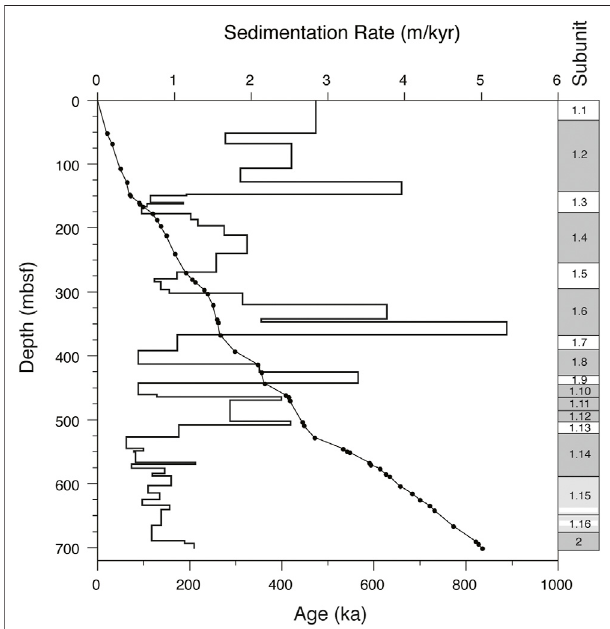
FIGURE8| CombinedplotshowingtheRPI-calibratedagemodel(black dots connected by a line) for Hole M0079A and the calculated sedimentation rates (continuous black line). Lithostratigraphic units are shown on the